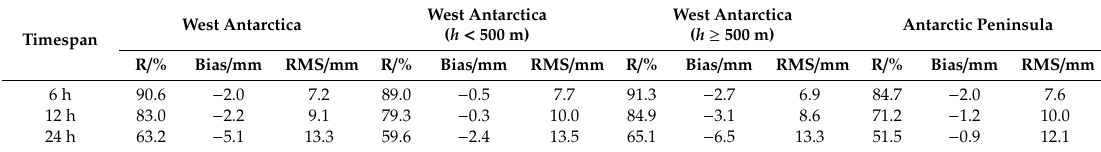
Table 3. Correlation coe ffi cient R, bias, and RMS between the forecasting results and GPS-ZTD. West Antarctica West Antarctica West Antarctica Antarctic Peninsula ( h < 500 m) ( h ≥ 500 m) Timespan R / % Bias / mm RMS / mm R / % Bias / mm RMS / mm R / % Bias / mm RMS / mm R /